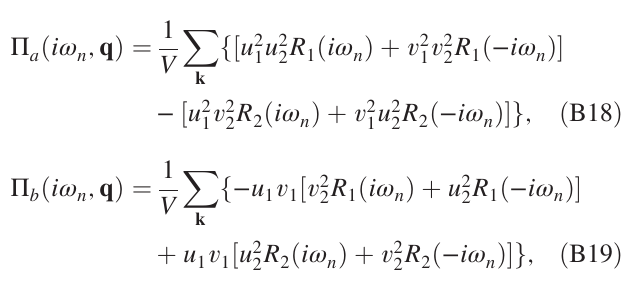
, u 2 ¼ u k , v 1 ¼ v k , v 2 ¼ v k as in the where u 1 ¼ u k þ q þ q main text, R 1 and R 2 are defined in Eqs. (62) and (63), and Π and Π are defined in Eqs. (70) and (71) of the c d main text. We renormalize the interaction in the standard way as given in Eq. (A2). In particular, this implies that the 22 and the 33 components of T − 1 ¼ ð 1 =g Þ − Π remain finite, as the divergence of 1 =G cancels a divergence in Π 22 . The 11 and the 44 components of T − 1 , however, diverge. Computing the T matrix, we note that only the components with two ingoing or outgoing lines are nonzero: